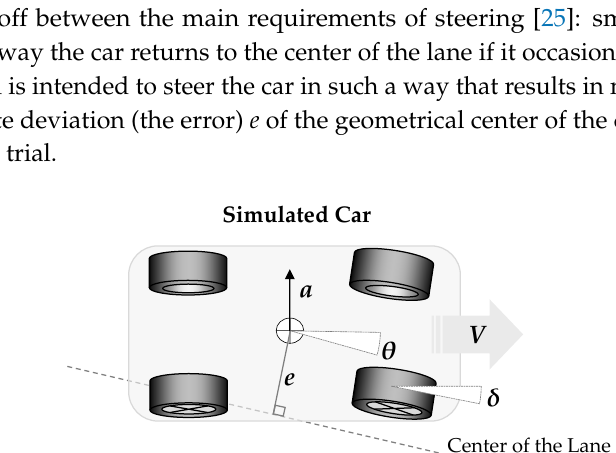
Figure 4. Servo-control model of steering as a proportional-derivative (PD) steering controller. The steering angle function (SAF), defining the steering angle δ , is implemented as the sum of the proportional (P) and derivative (D) terms of the error: the deviation e from the center of the lane.